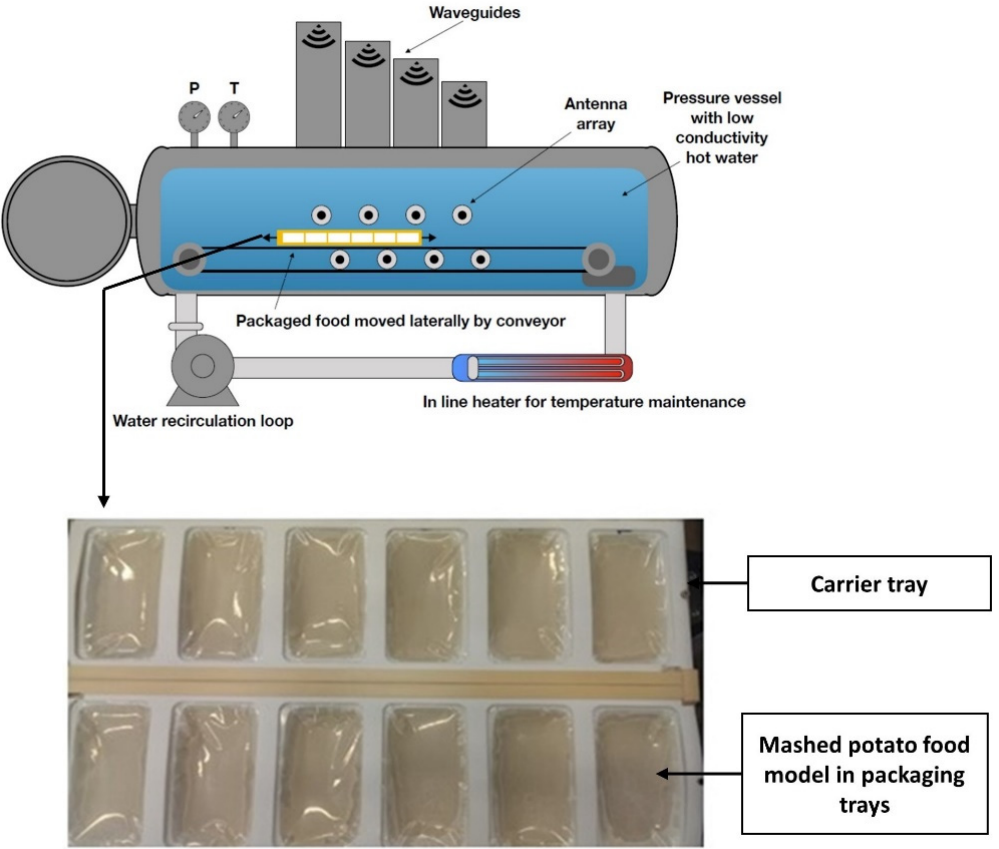
Figure 1. Schematic representation showing the mashed potato food model packed in the packaging trays and arranged in carrier tray while kept immersed in hot / warm water inside the pressure vessel in Coaxially induced microwave pasteurization and sterilization (CiMPAS).